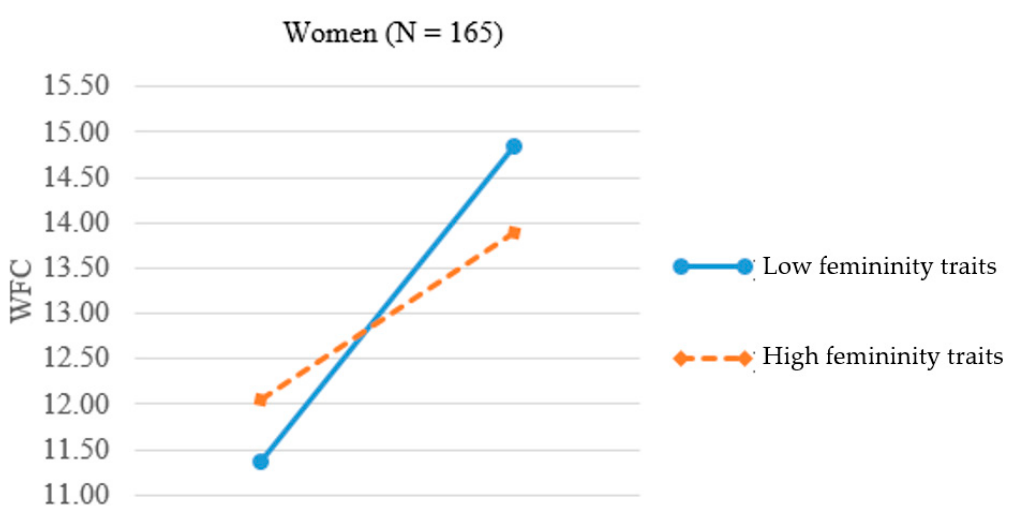
Figure 4. Interaction of femininity traits and family responsibility on WFC for women.